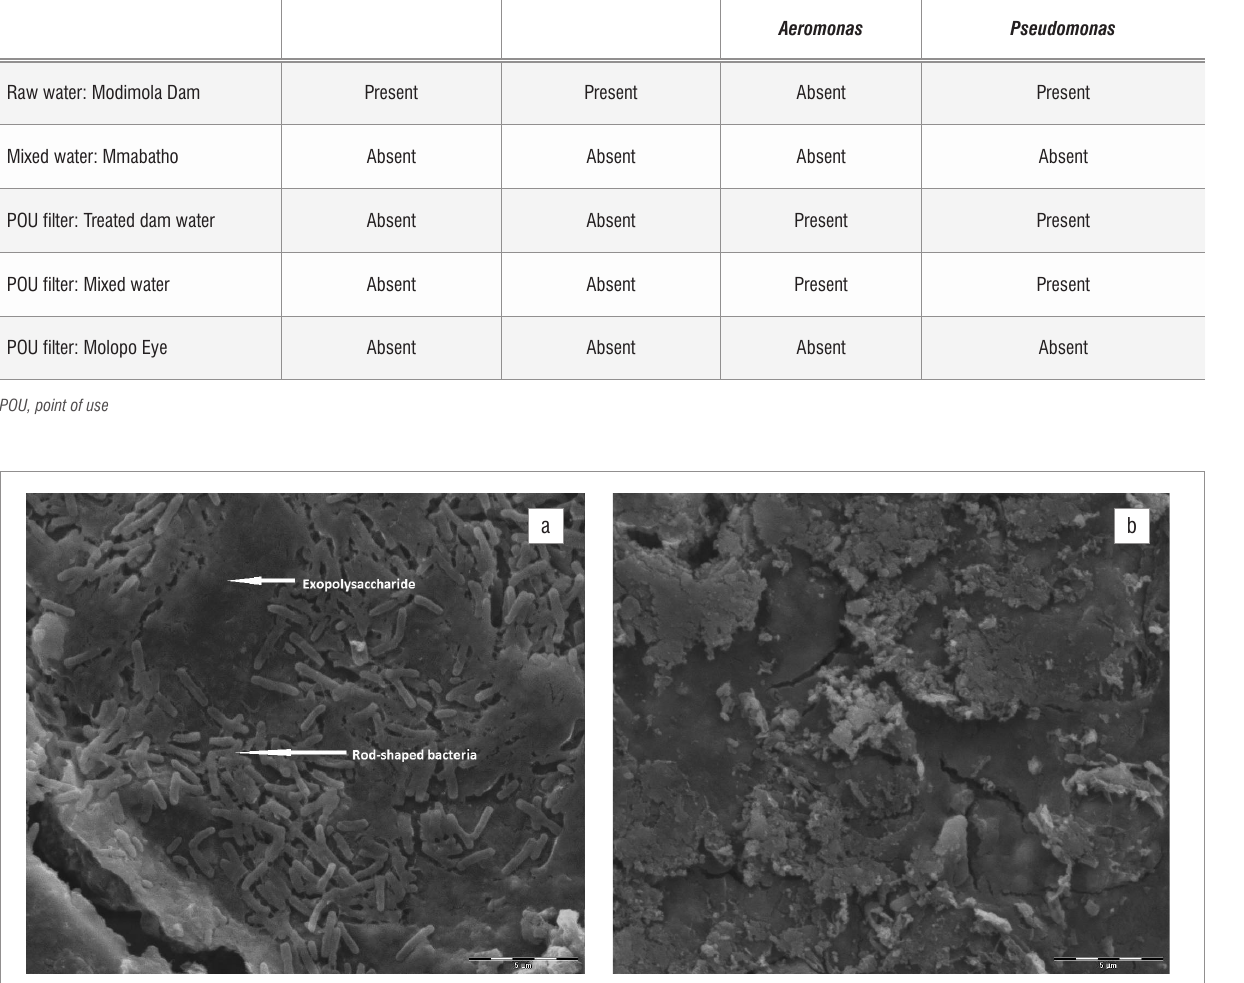
Aeromonas Pseudomonas